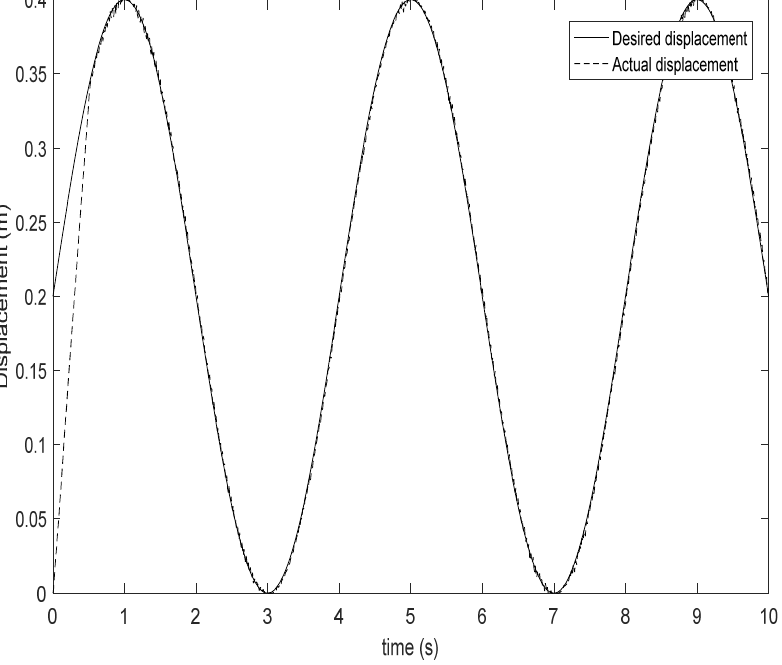
Figure 6. Curves of control variables under different reaching laws. A bounded white noise interference signal was added to the given sinusoidal signal, and the exponential reaching law and the adaptive reaching law SMC controllers were used for the simulation, respectively. It can be seen from Figures 7 and 8 that the displace ‐ ment tracking effect of the adaptive reaching law SMC algorithm is obviously better than that of the exponential reaching law SMC algorithm, after being disturbed. The proposed adaptive reaching law SMC controller improves the robustness of the system.